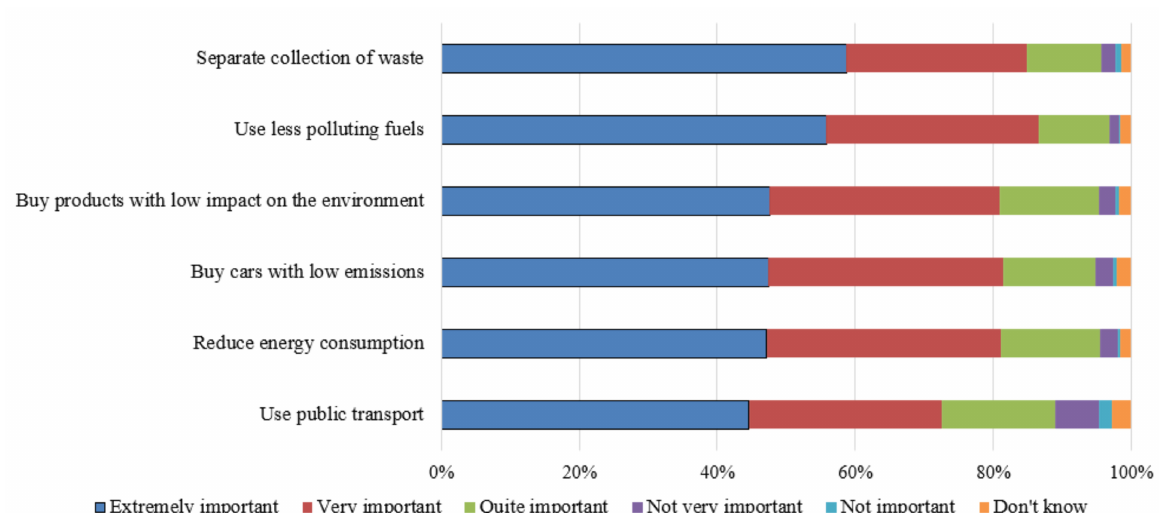
Figure 3. Level of importance attributed to behaviors of citizens in the fight against